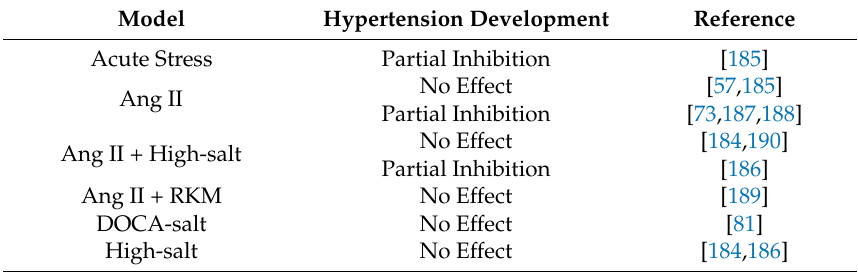
Table 3. Effect of IL-6 Deficiency in Experimental Models of